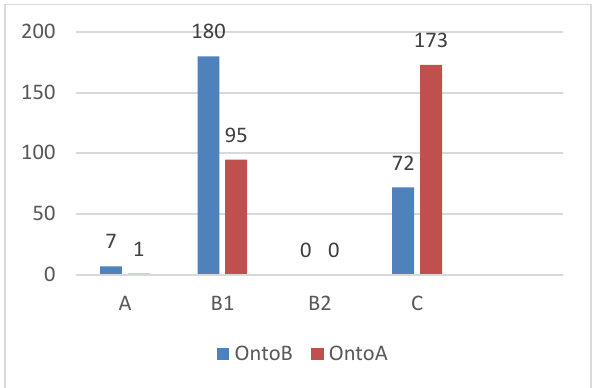
Figure 3. Number of question